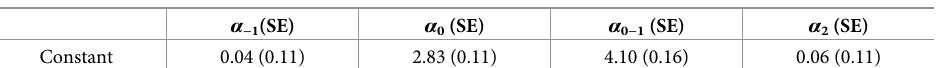
Table 8. Regression constant.